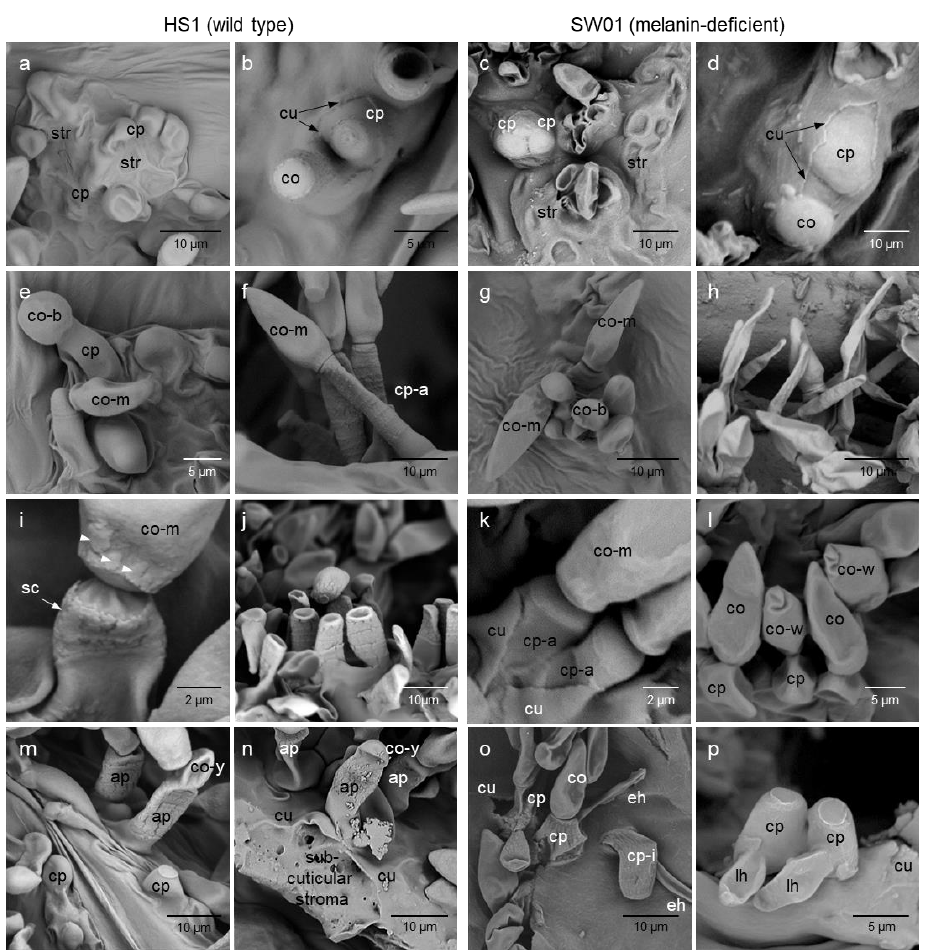
Figure 5. Conidiogenesis of Venturia inaequalis isolates HS1 (wild-type, ( a , b , e , f , i , j , m , n )) and SW01 (melanin-deficient mutant; ( c , d , g , h , k , l , o , p )) on apple leaves. Formation of secondary stroma (str) with conidiophores (cp) before ( a , c ) and after penetration of the plant cuticle ( b , d ); the cuticle tightly encloses the conidiophore, start of conidia (co) formation; conidia formation begins with an epicuticular balloon-like structure (co-b) which matures into the typical pear shape of mature V. inaequalis conidia (co-m; ( e , g )); older conidiophores become typically annellate for HS1 (cp-a; ( f )), whereas conidiophores of SW01 often are transformed into superficial hyphae ( h ); release of mature conidia (co-m) from conidiophores for HS1 and SW01 with and without prominent scars (sc) on the surface of conidiophore and conidium, respectively ( i , k ); remaining annellate conidiophores of HS1 ( j ) and wrinkled conidia (co-w) of SW01 still attached to the conidiophores ( l ); formation of a new conidium (co-y) on an older conidiophore ( m ), link between sub-cuticular stroma and epicuticular conidiophore (N) for HS1; conidiophores of SW01 sometimes lack rigidity (cp-i; ( o )) or form lateral hyphae (lh) resulting in epicuticular hyphal growth ( p ). Scanning electron images taken at different stages of sporulation (6 to 14